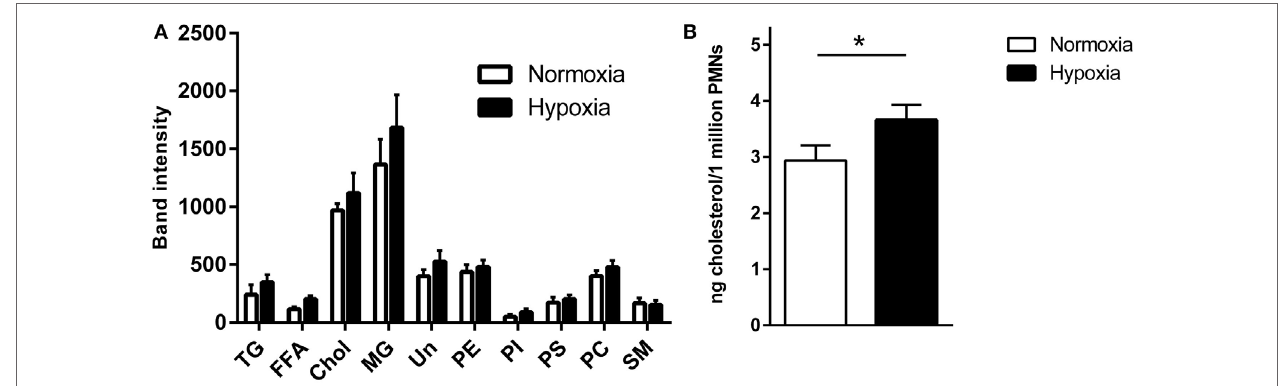
FiGUre 4 | the cellular cholesterol content increased under hypoxia . Neutrophils were incubated in either 1 or 21% oxygen, and their lipid composition was analyzed by TLC (a) : triglycerides (TG), free fatty acids (FFA), cholesterol (chol), monoacylglycerols (MG), unknown (UN), phosphatidylethanolamine (PE), phosphatidylinositol (PI), phosphoserine (PS), phosphatidylcholine (PC), and sphingomyelin (SM). Furthermore, cholesterol content was analyzed via HPLC (B) . Results are expressed as nanogram cholesterol per 1 × 10 6 neutrophils. A significant higher cellular cholesterol level was detectable after incubation under hypoxia compared to normoxia. Statistical analysis was performed with one-tailed paired Student’s t